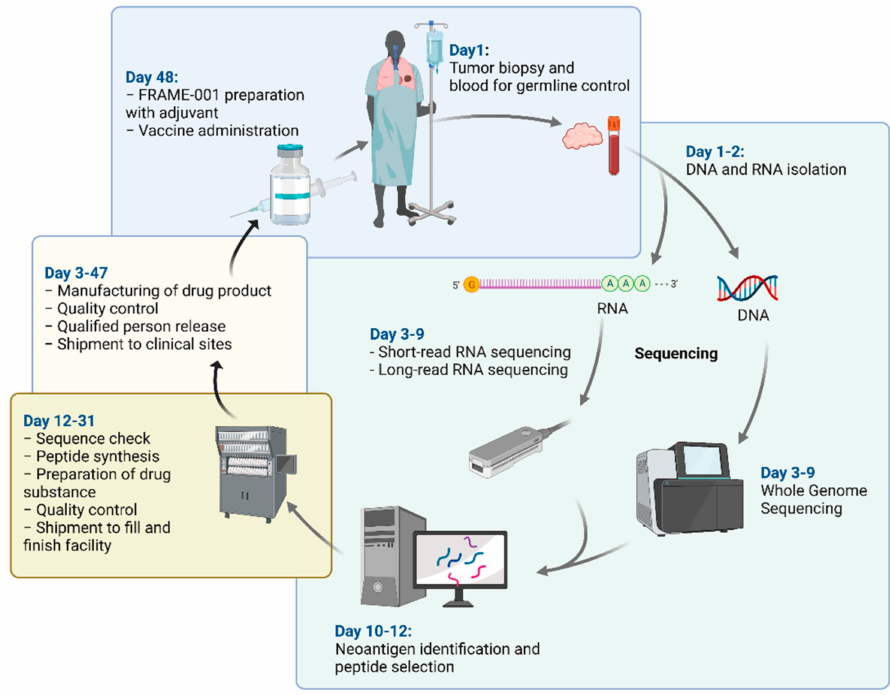
Figure 1. Schematic representation of the entire manufacturing process of FRAME-001.